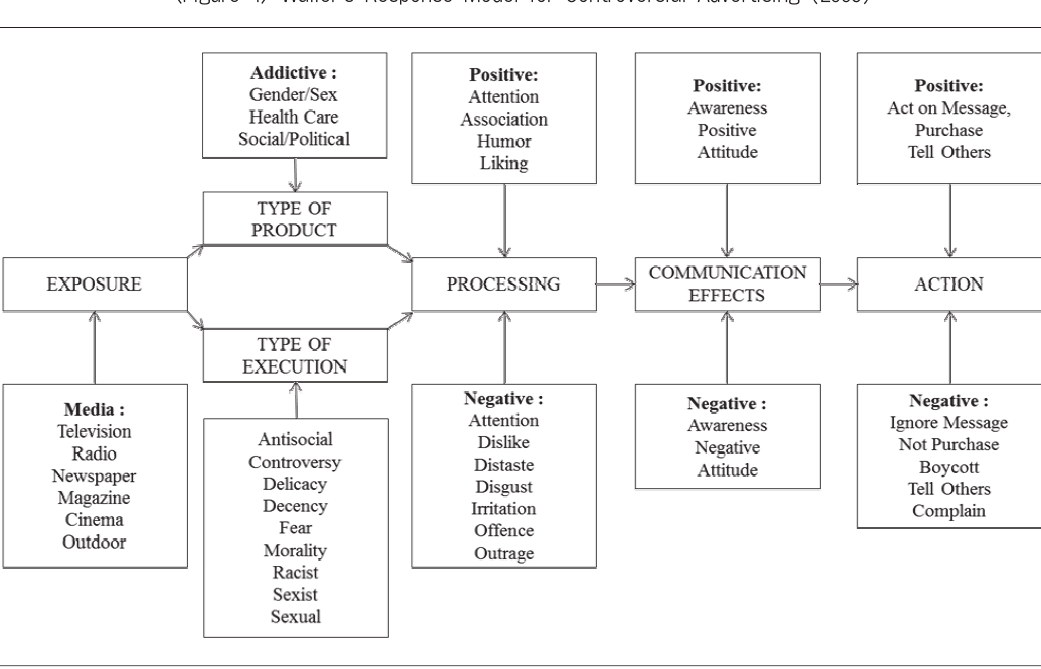
<Figure 4> Waller's Response Model for Controversial Advertising